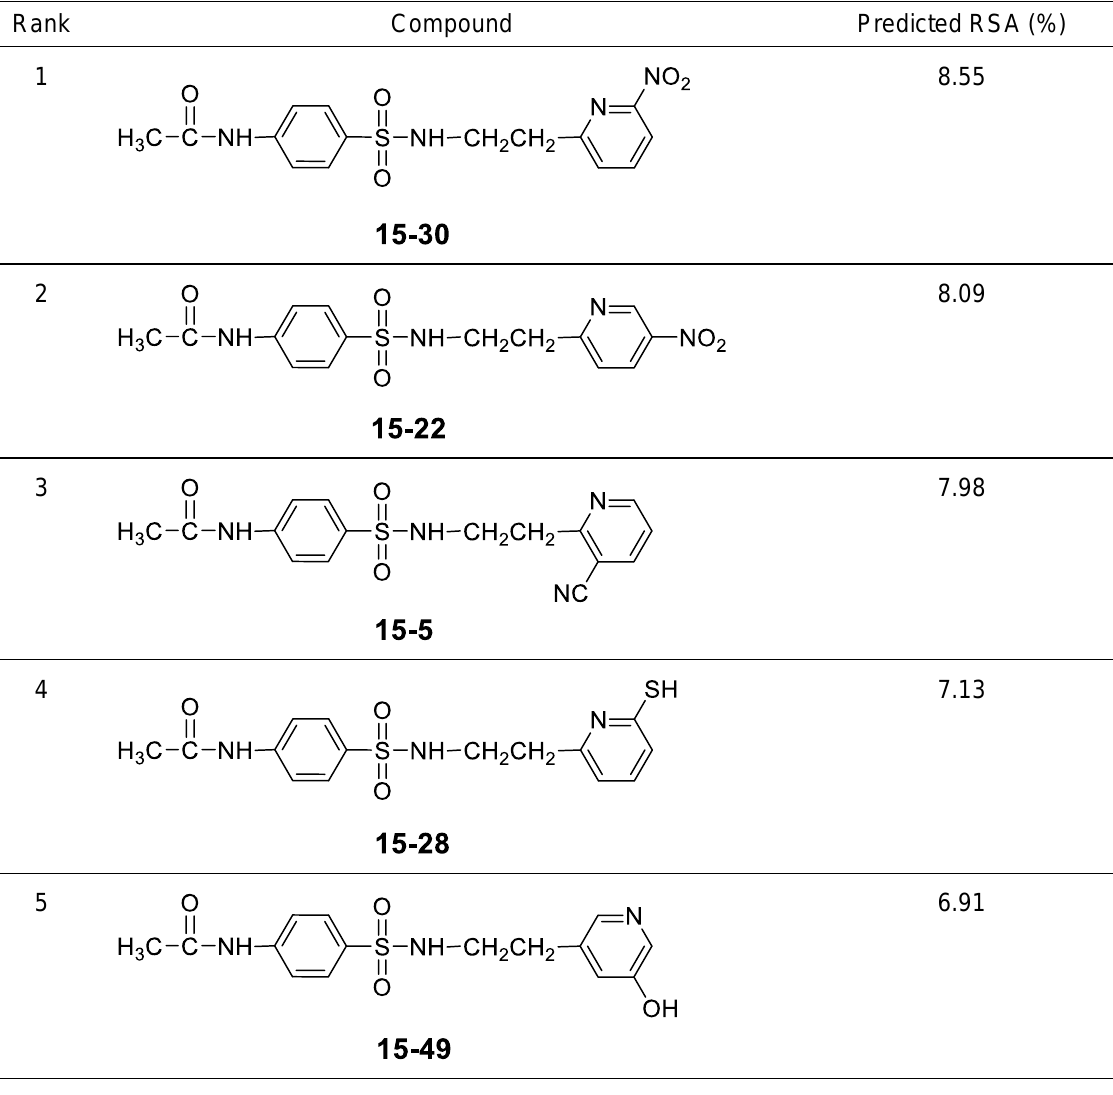
Table 6: Top five of predicted new sulfonamides with RSA